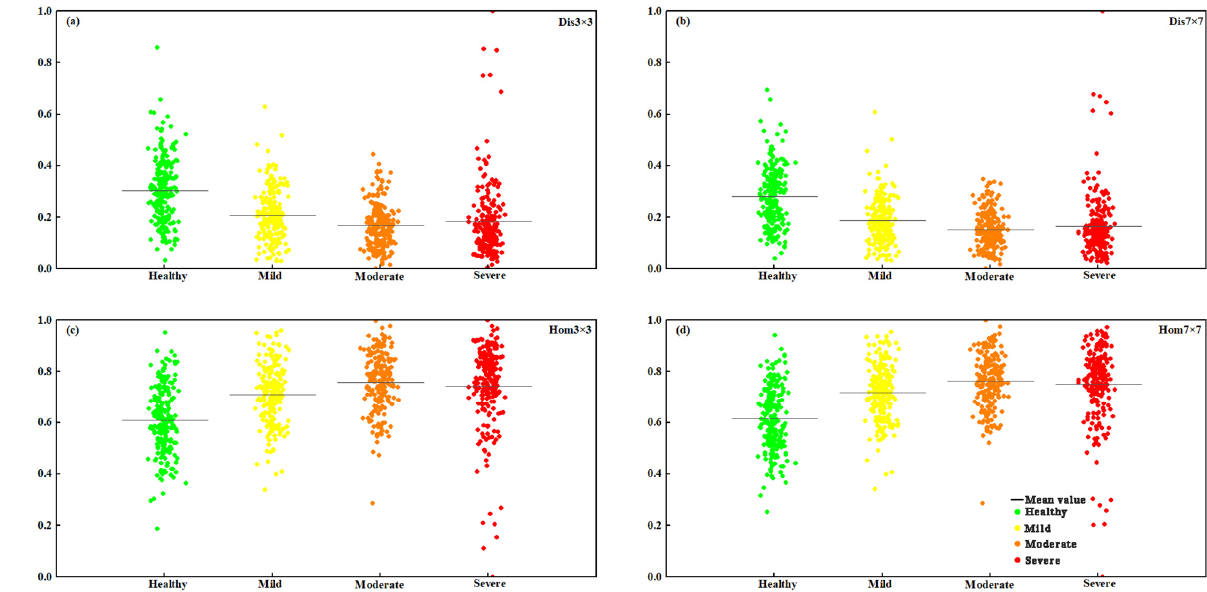
Figure A2. Variation characteristics of sensitive texture features of forest trees with different degrees of damage: ( a ) dissimilarity of 3 × 3 windows, ( b ) dissimilarity of 7 × 7 windows, ( c ) homogeneity of 3 × 3 windows, ( d ) homogeneity of 7 × 7 windows.